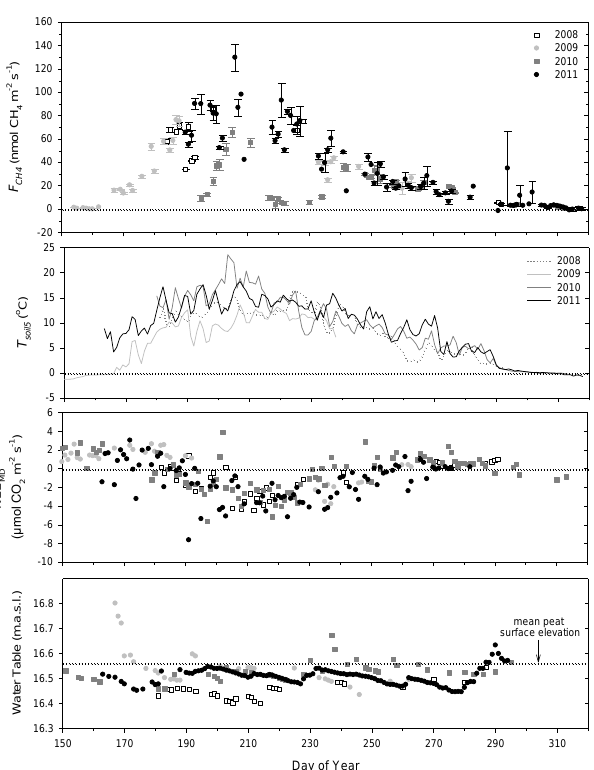
Fig. 2. Mean daily F CH (no gap-filling) for 30min averaged cam- 4 paign periods ( n = 1 to 48) ± 1 SE (standard error) shown, and mean daily T soil5 , NEE MD and water table height for all shoul- der + growing seasons (DOY 150–320, 2008–2011).